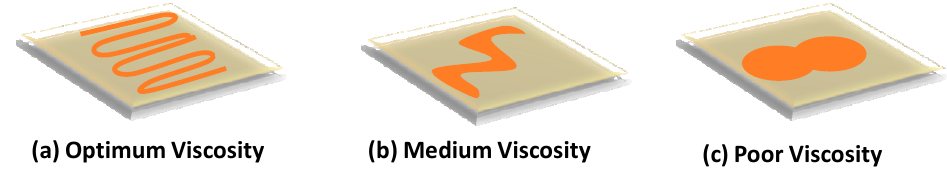
Figure 6. The level of printing viscosity for bioinks: ( a ) optimum viscosity; ( b ) medium viscosity; ( c ) poor viscosity.